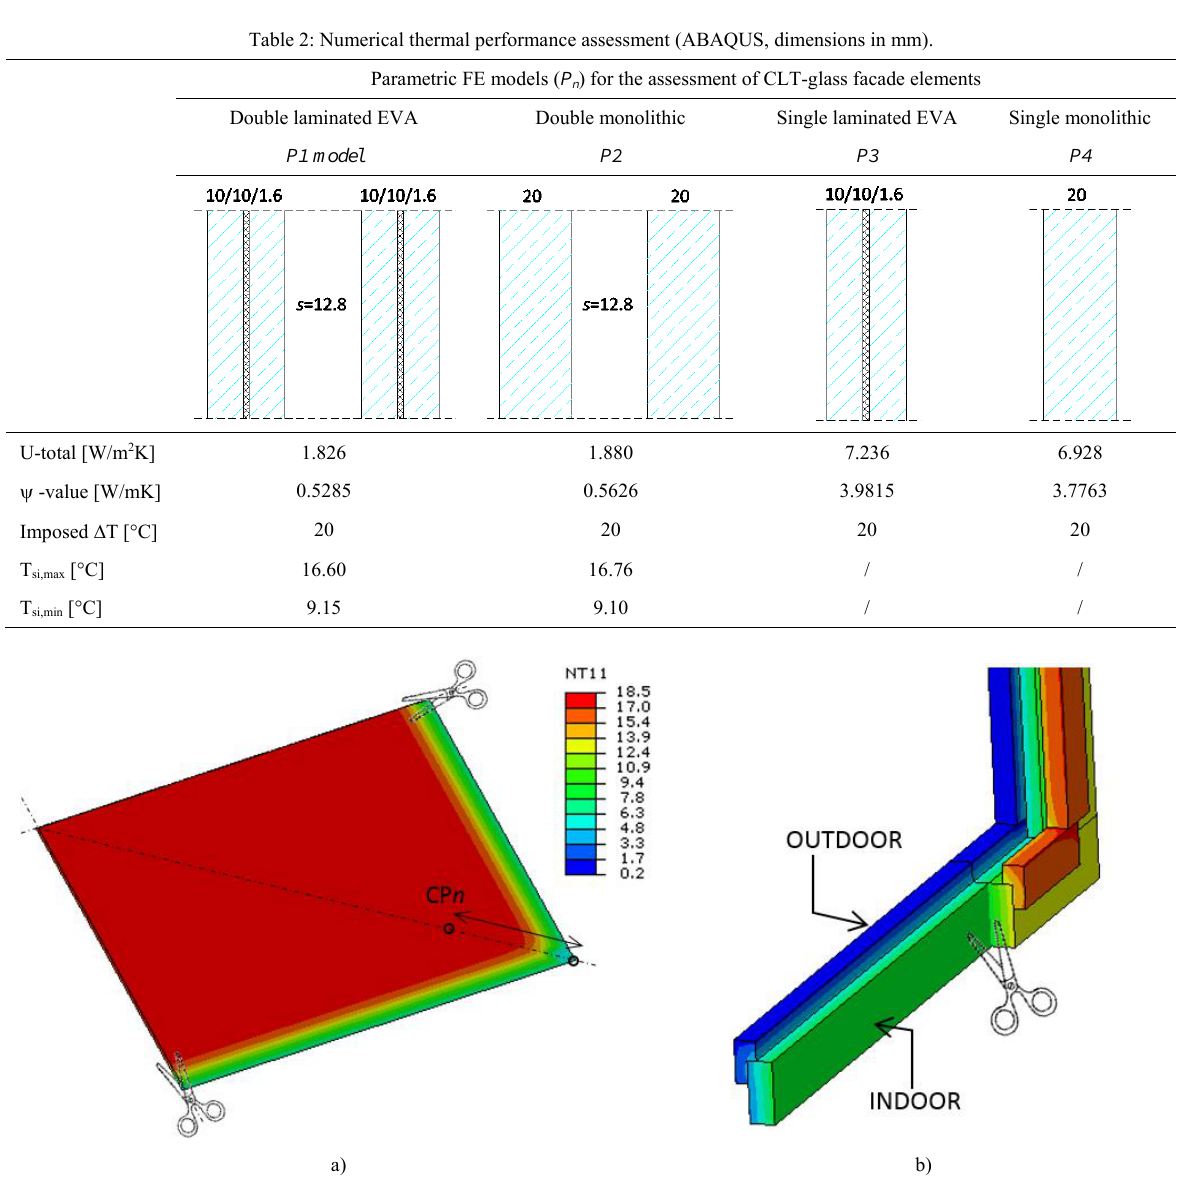
Fig. 9 FE thermal performance assessment of full-scale CLT-glass facade elements (P1 model). Expected distribution of temperature a) in the internal glass panel (external side) and b) timber frame (ABAQUS, values in